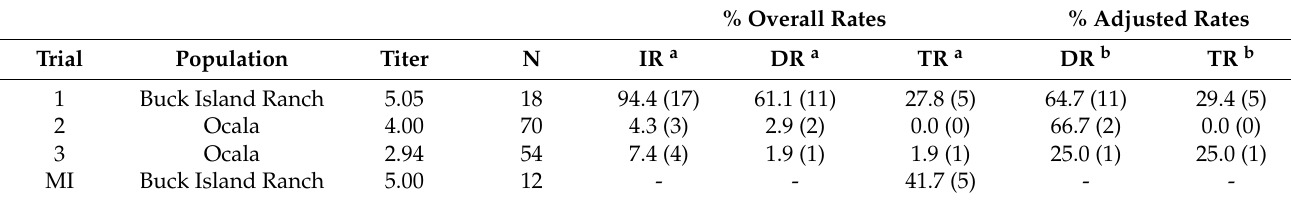
Table 1. Infection, dissemination, and transmission rates of Culicoides insignis orally infected with EHDV-2 in trials 1, 2, and 3 as well as microinjected midges (MI). Titers shown in log 10 PFU equivalents/mL and numbers in parentheses show the number of samples positive from total tested. Only the transmission rate is shown for the microinjected trial since injection bypasses midgut infection and escape barriers.